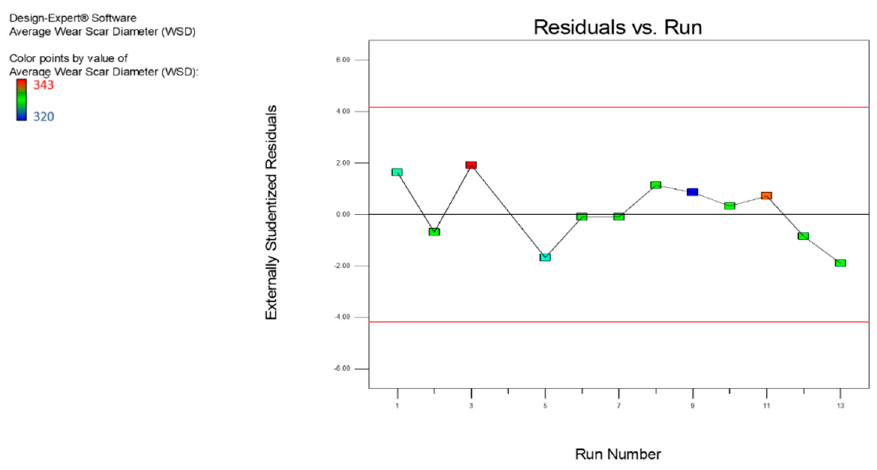
Figure 11. The residuals vs. the predicted average WSD for the MoS 2 nanolubricants.